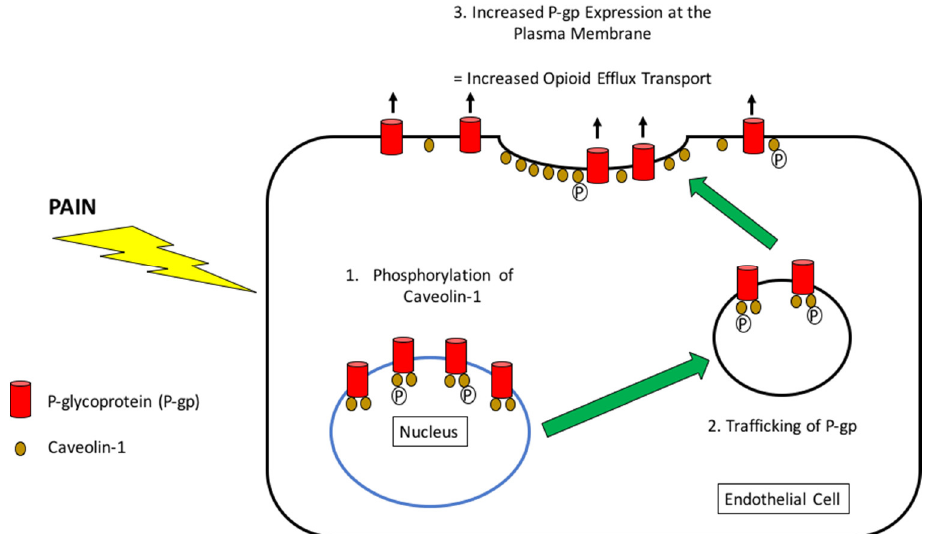
Figure 3. P-glycoprotein Trafficking in Brain Microvascular Endothelial Cells in Response to Acute Inflammatory Pain. Our laboratory has shown caveolin-dependent trafficking of P-glycoprotein (P-gp) from nuclear storage pools to the plasma membrane in the setting of acute inflammatory pain.